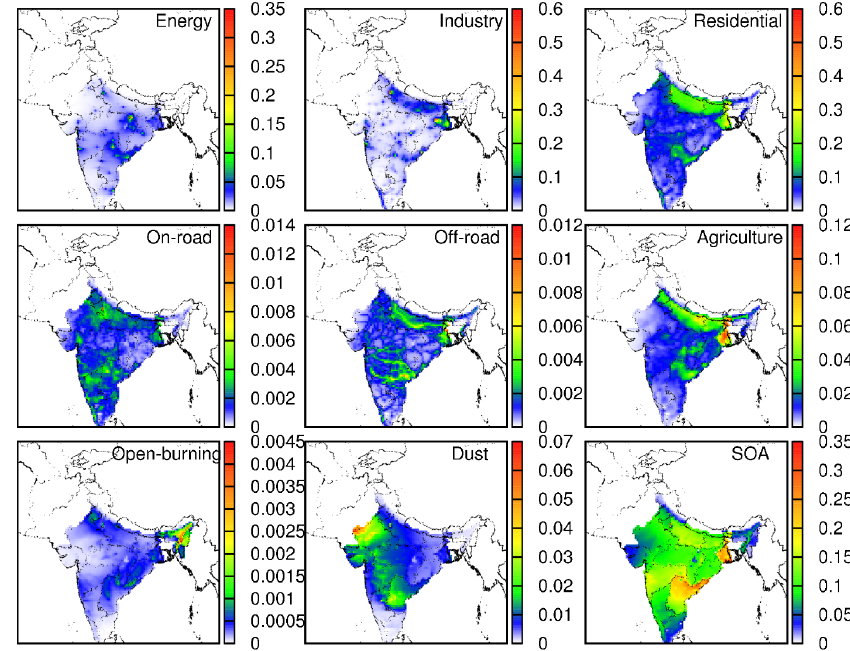
Figure 5. Contributions of different sources to years of life lost (YLL) based on population (years).